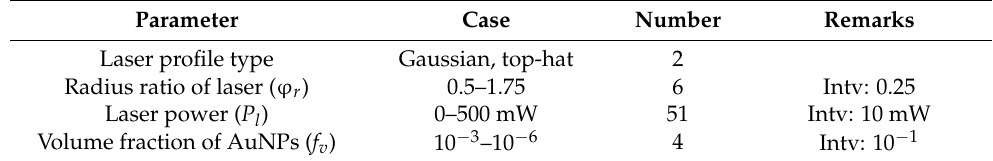
Table 3. Parameters of the numerical analysis.